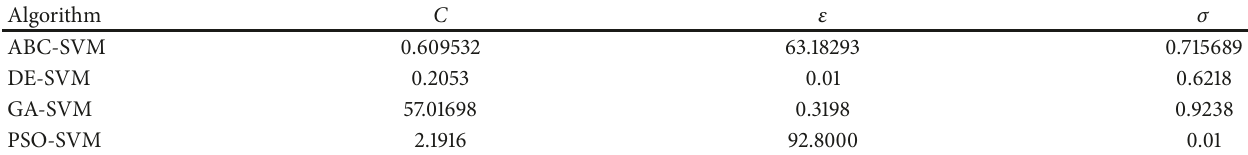
Table 9: Optimum internal parameters of SVM for Compacted Graphite Iron with minimizing MSE.